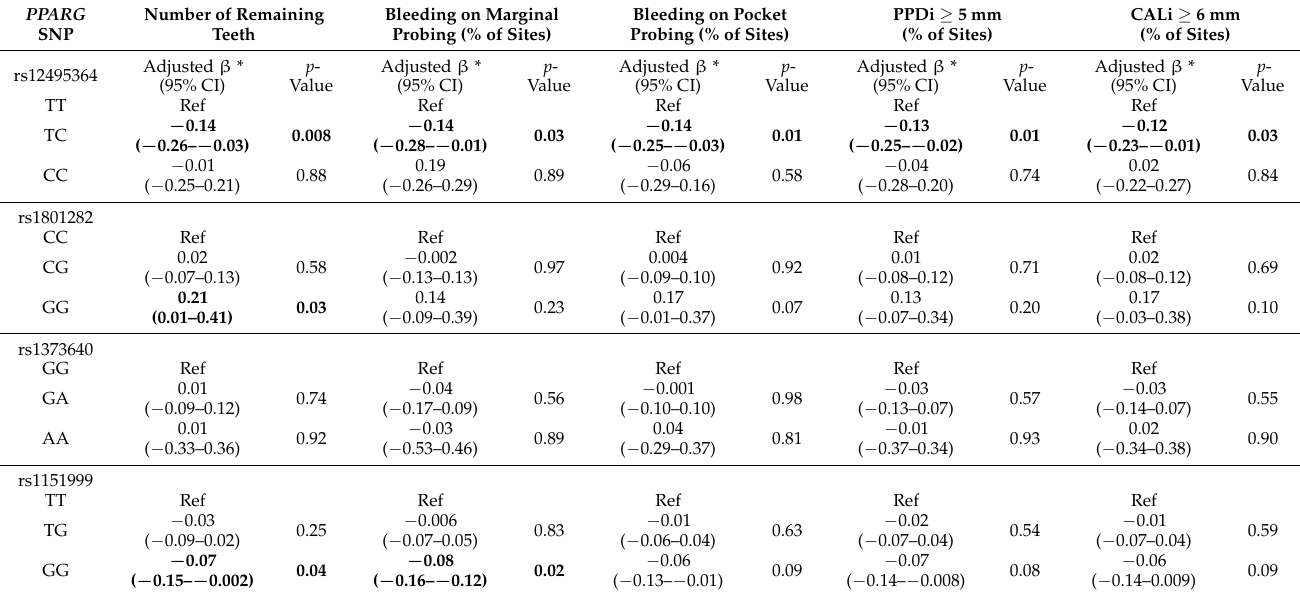
Table 4. Multiple linear regression analysis of all subjects for effects of single nucleotide polymor- phisms on periodontal